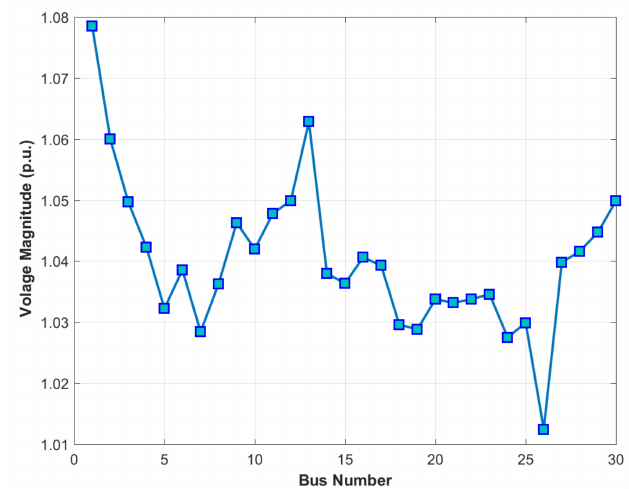
Figure 7. The voltage profile of the MRao-2 for case 2.